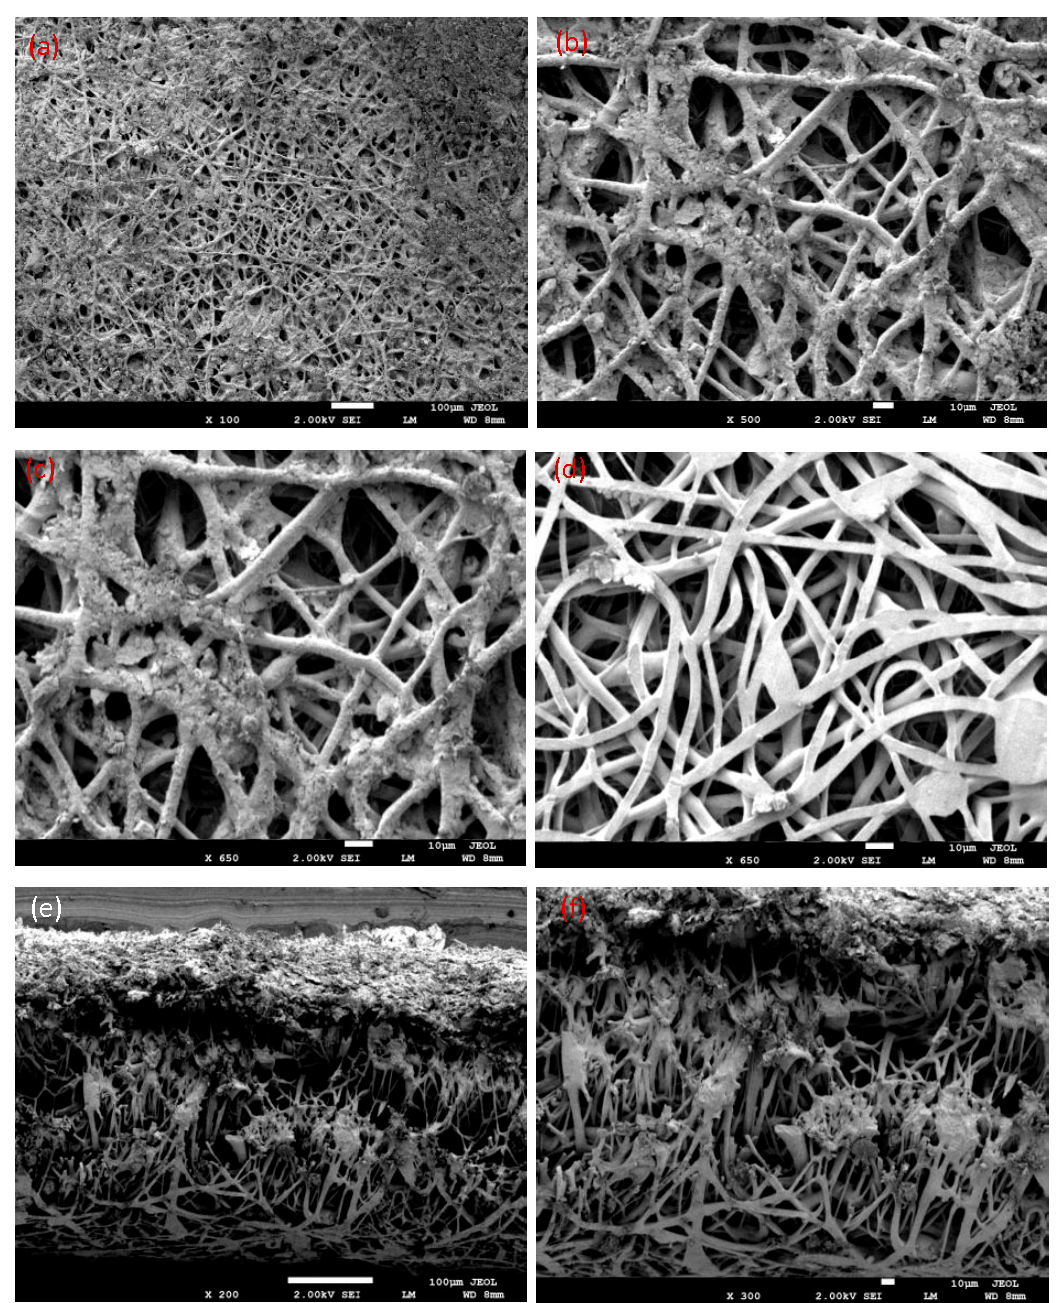
Figure 9. SEM images of nanoparticles and microparticles of fine sand from the Saudi Earth at the surface of the membrane after filtration process; ( a , b , c ) Top membrane layer with cylindrical fibers; ( d ) Bottom membrane layer with flat fibers; ( e , f ) Cross-section of the membrane with different scales.